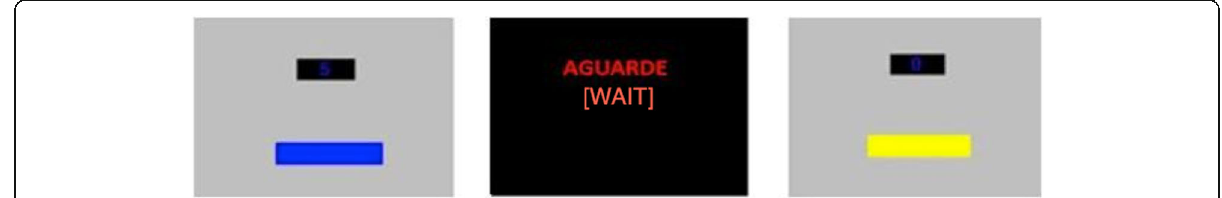
Fig. 1 Computer monitor at three different moments: VT component, 5-s timeout period, and EXT component. During timeout, we presented the word “ aguarde ” in Portuguese, which can be translated into English by “ wait